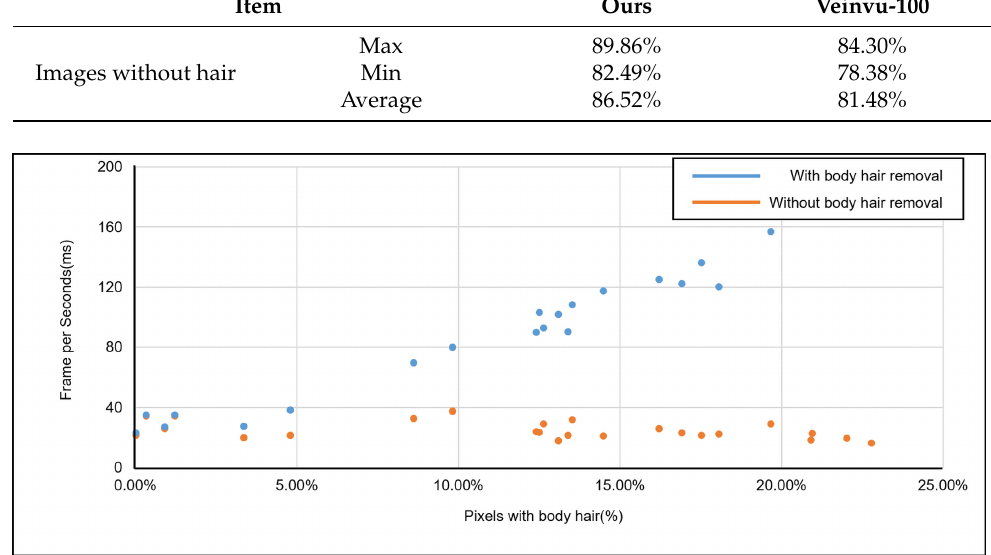
Figure 21. Proposed Algorithm Operation Speed Measurement